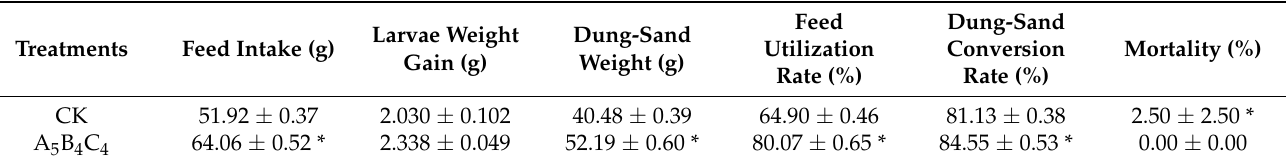
Table 7. Transformation capability of the 3rd instar larvae of P. brevitarsis under the optimal combination. Larvae Treatments Feed Intake (g)